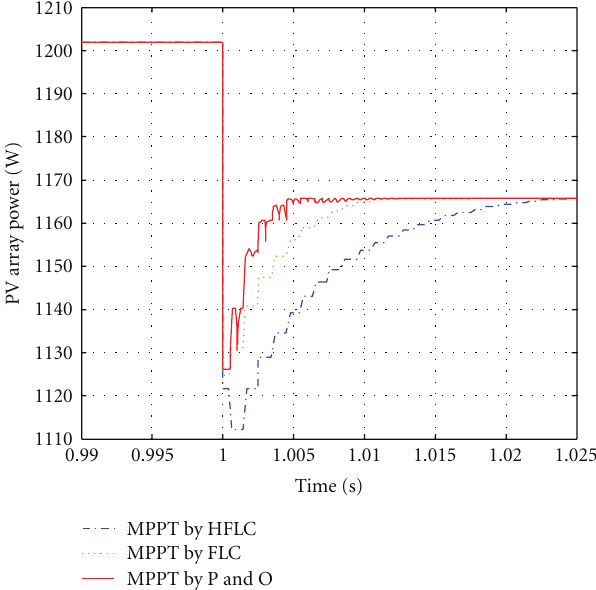
Figure 23: PV output power under partial shading with of solar irradiation change 1000 W/m 2 to 950W/m 2 .